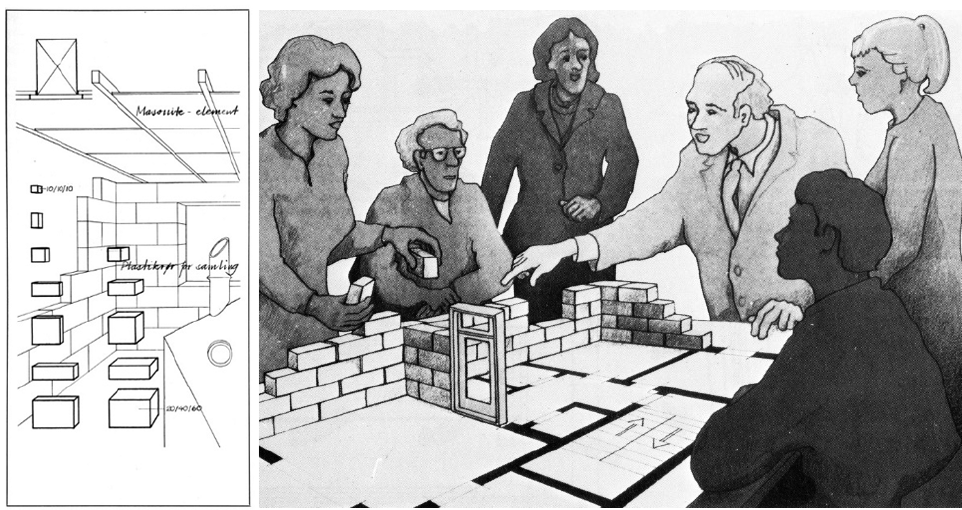
Figure 6. Building full-scale models at the ROL. From right to left: Schematic diagram of the elements for building full-scale models at the ROL; Image from the booklet Residents in the Design Team , published by Amsterdam’s Municipal Housing Department. Source: Dinesen (1982, pp.